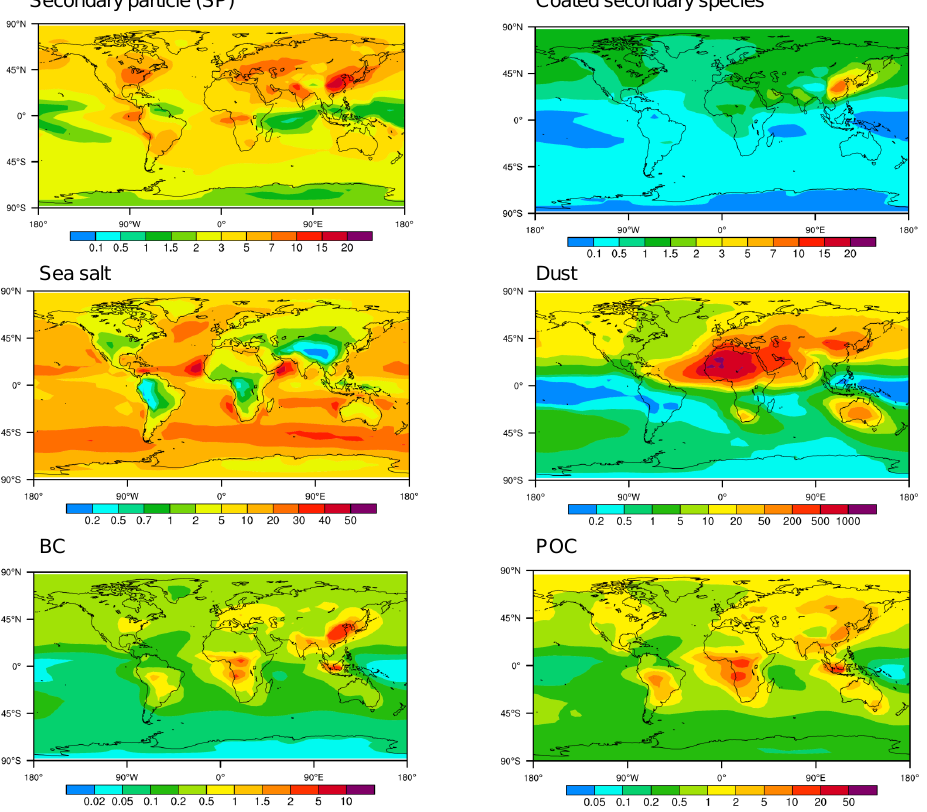
Fig. 1. Modeled annual mean aerosol burden (Unit: mg m − 2 ) from GEOS-Chem-APM model.